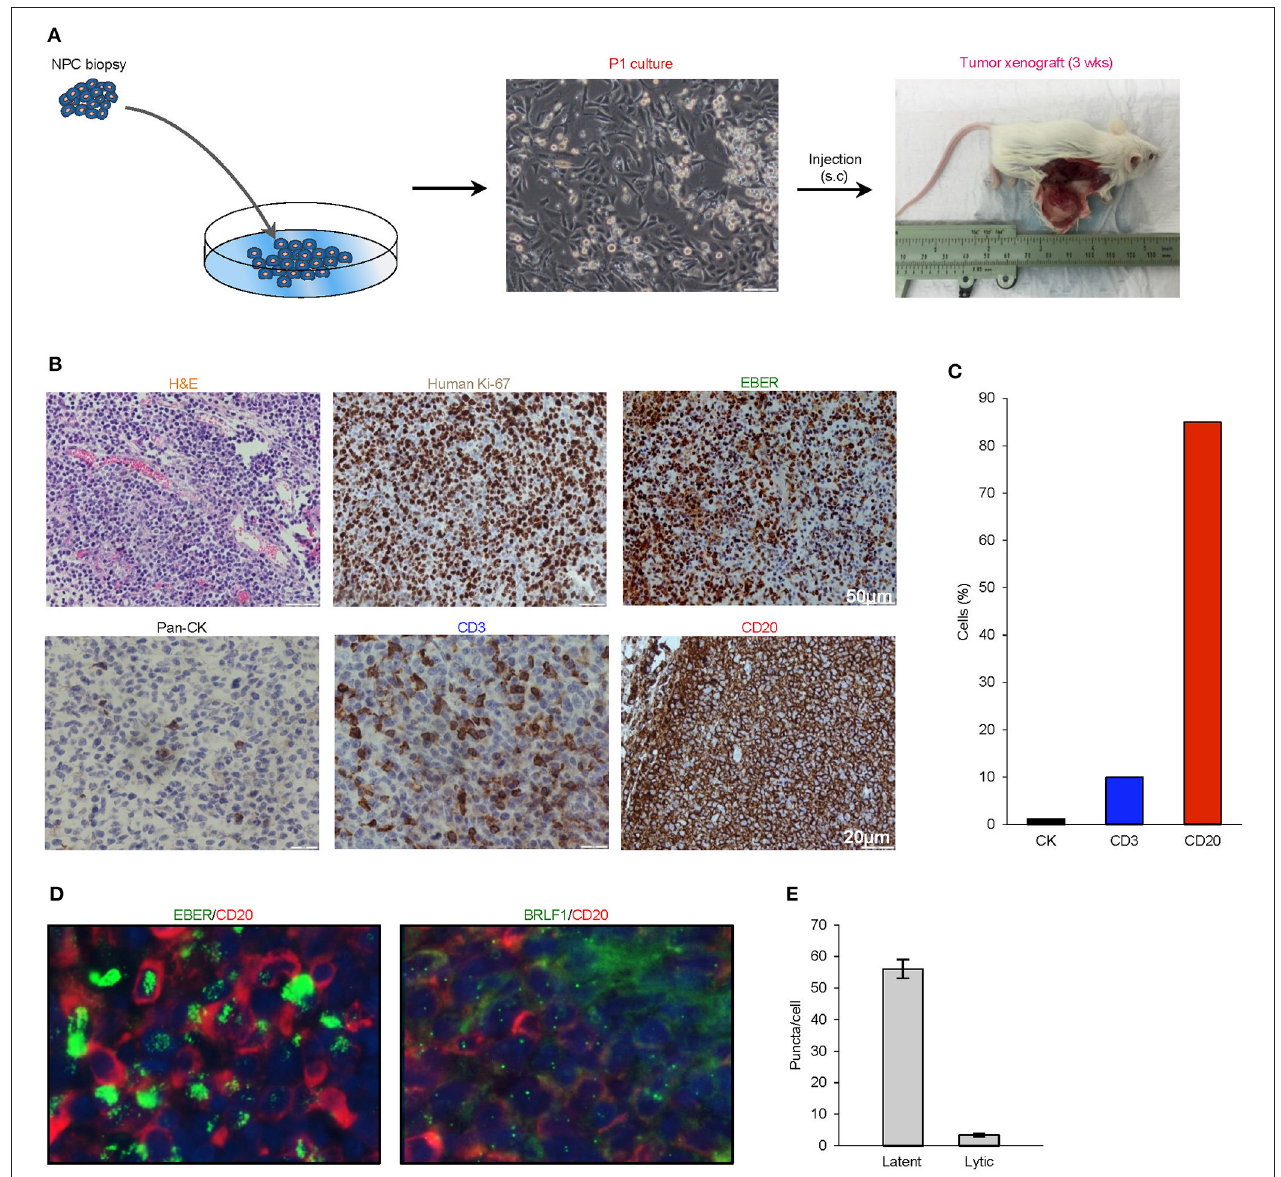
FIGURE 1 | Histological characterization of P1 culture and parental xenograft. (A) A biopsy was obtained from a 38-year-old Singaporean Chinese male with nasopharyngeal carcinoma. The majority of cells in the P1 culture exhibited a typical polygonal, cuboidal epithelial appearance, occasionally seen along with spindle-shaped fibroblasts and floating small round cells loosely attached to the well. NOD-scid IL2r γ null (NSG) mice were subcutaneously implanted with trypsinized cells, and the xenograft tumor was harvested at a diameter of ∼ 15mm at ∼ 3 weeks after transplantation. (B) Analysis of histology (H&E), species origin and mitotic rate (human specific Ki67), EBV status (EBER), and tissue composition (lineage markers: pan-CK, CD3, and CD20). (C) Bar graph showing the composition of cell types by lineage markers of the tumor xenograft. (D,E) 4.0 µ m tissue sections were in in situ hybridized with EBV latent- and lytic-specific RNA probes EBER and BRLF1 respectively, followed by immunohistochemical staining with the B-lymphocyte marker CD20. Positive ISH signals were localized within the cell nuclei as green fluorescent puncta, while CD20 was localized on the cell